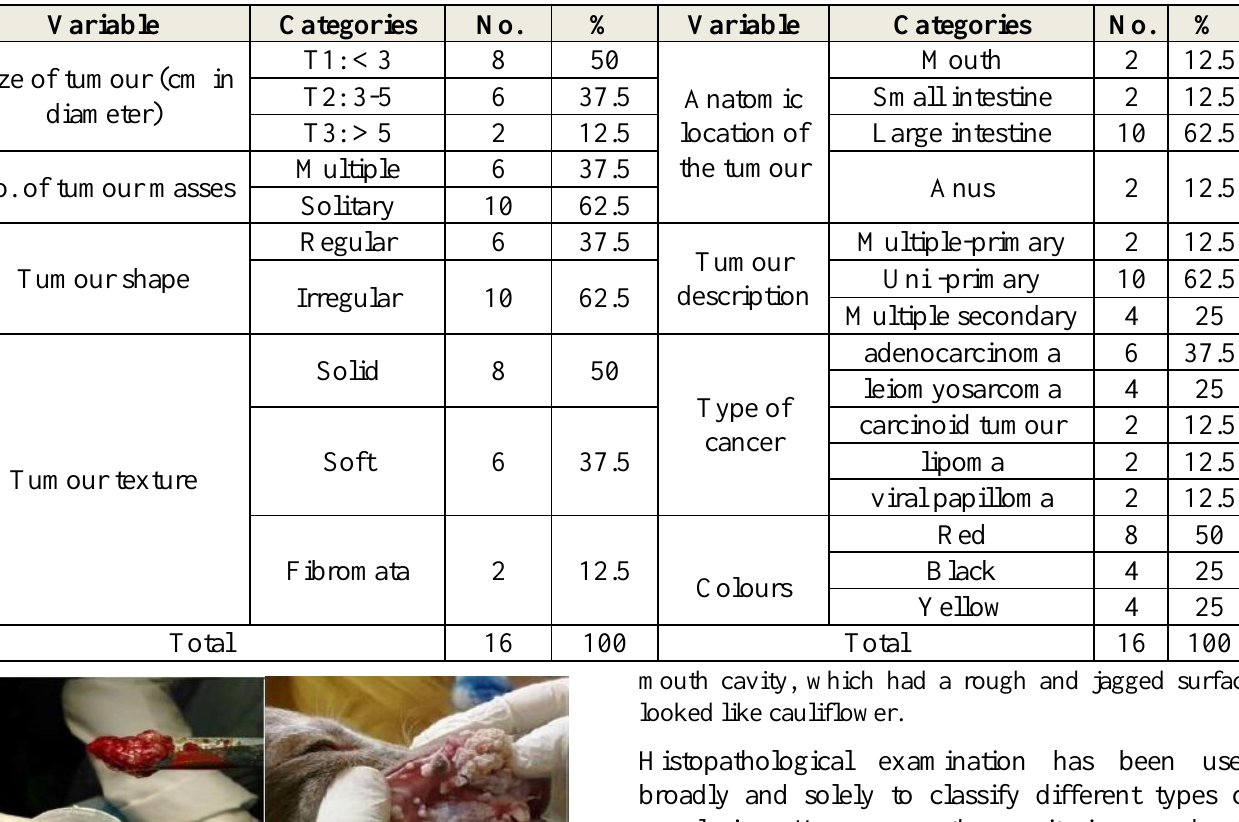
mouth cavity, which had a rough and jagged surface looked like